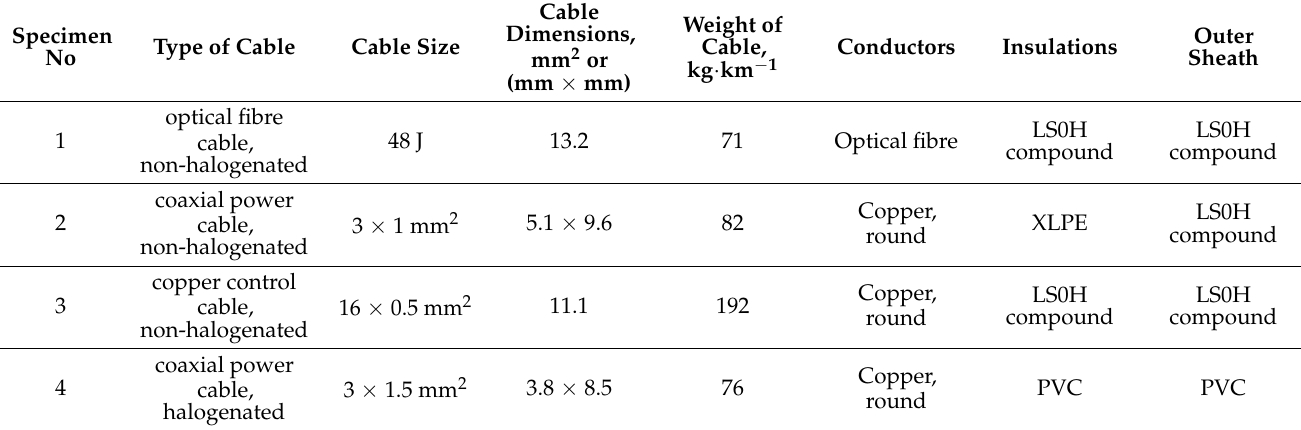
Figure 2. Cone calorimeter: ( a ) external view on the test apparatus, ( b ) cable specimen during the test, at the accredited Fire Testing Laboratory ITB in Pionki, Poland. Table 2. Characteristics of cables tested by means of cone calorimeter and large geometric scale test methods. Specimen